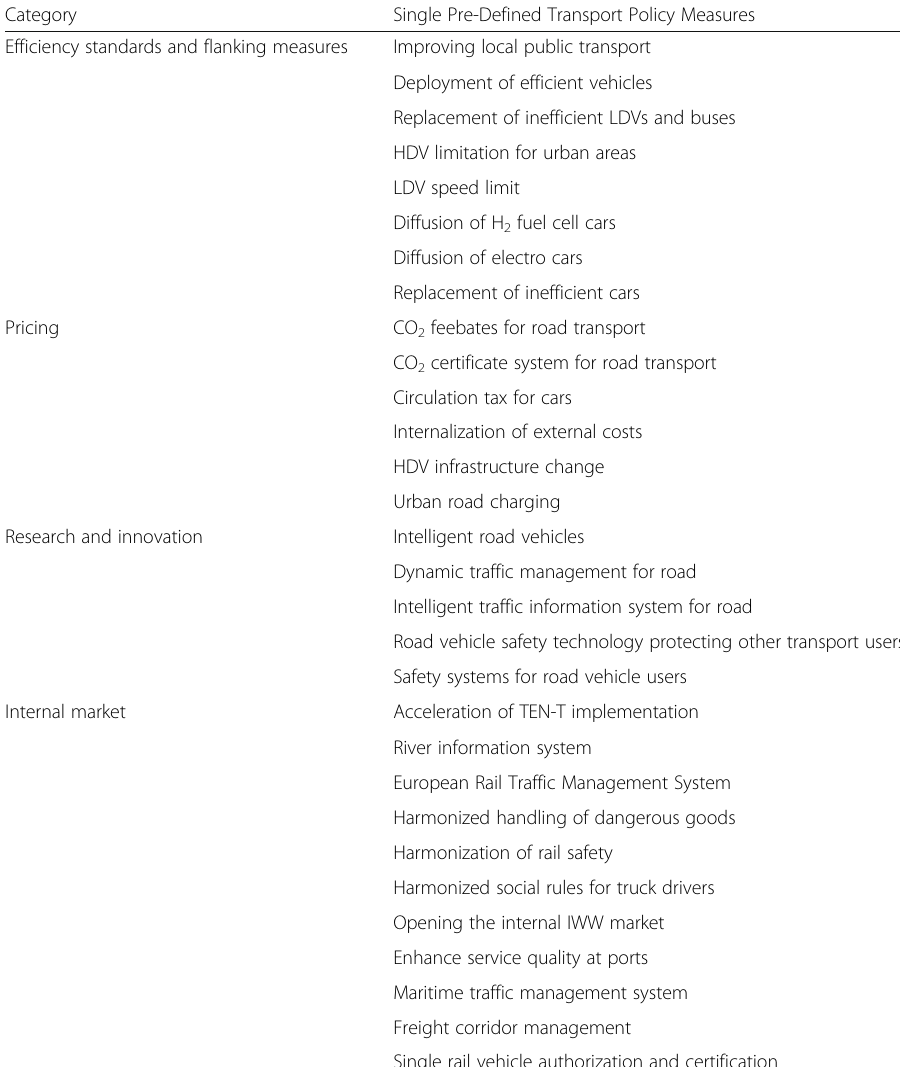
Table 3 Transport Policy Measures covered by HIGH-TOOL